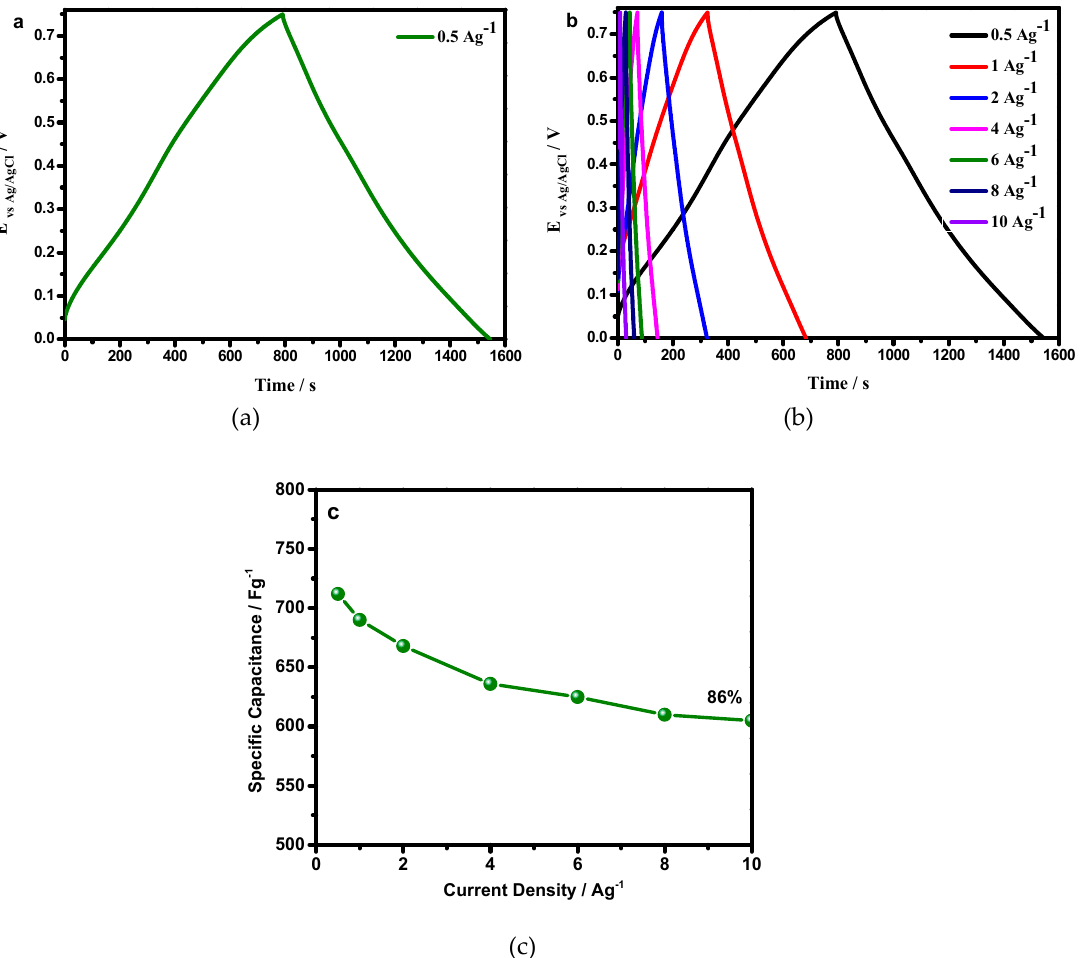
Figure 6. Galvanostatic Charge Discharge (GCD) curves of PANI–DBSA, ( a ) at 0.5 Ag − 1 , ( b ) at a different current density, ranging from 0.5–10 Ag − 1 , and ( c ) rate capability with a current density growth from 0.5–10 Ag − 1 .